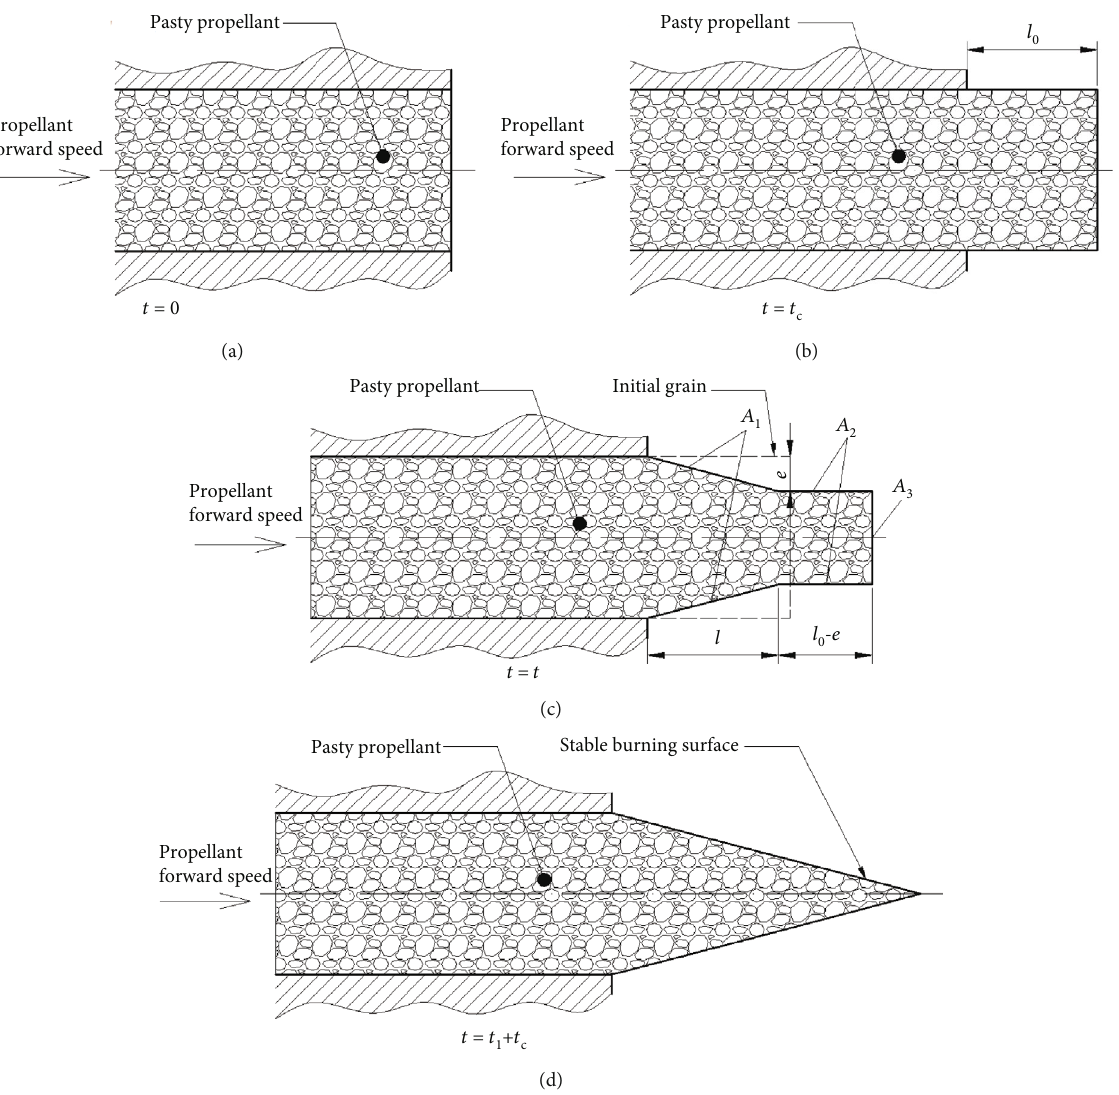
Figure 2: Burning surface change process of pasty propellant at the initial stage.